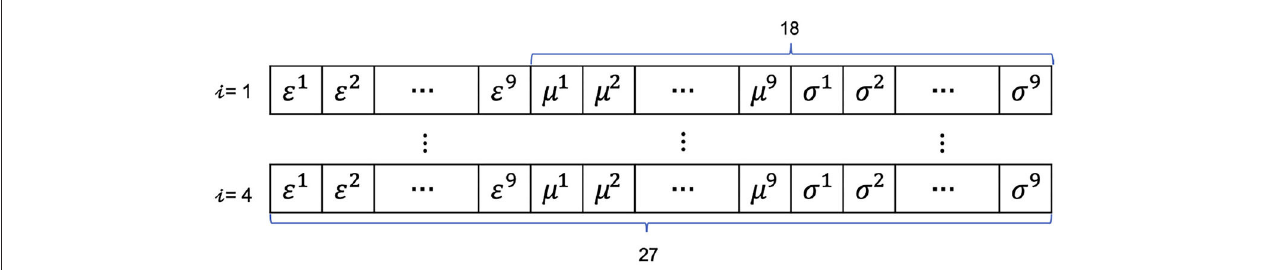
FIGURE 1 | The features and the shape of model input, i represents the i th 2 s, and a sample of input consists of 8 s. The ( ε , µ , σ ) and ( µ , σ ) features combinations are represented by the structure of 27 and 18, respectively.